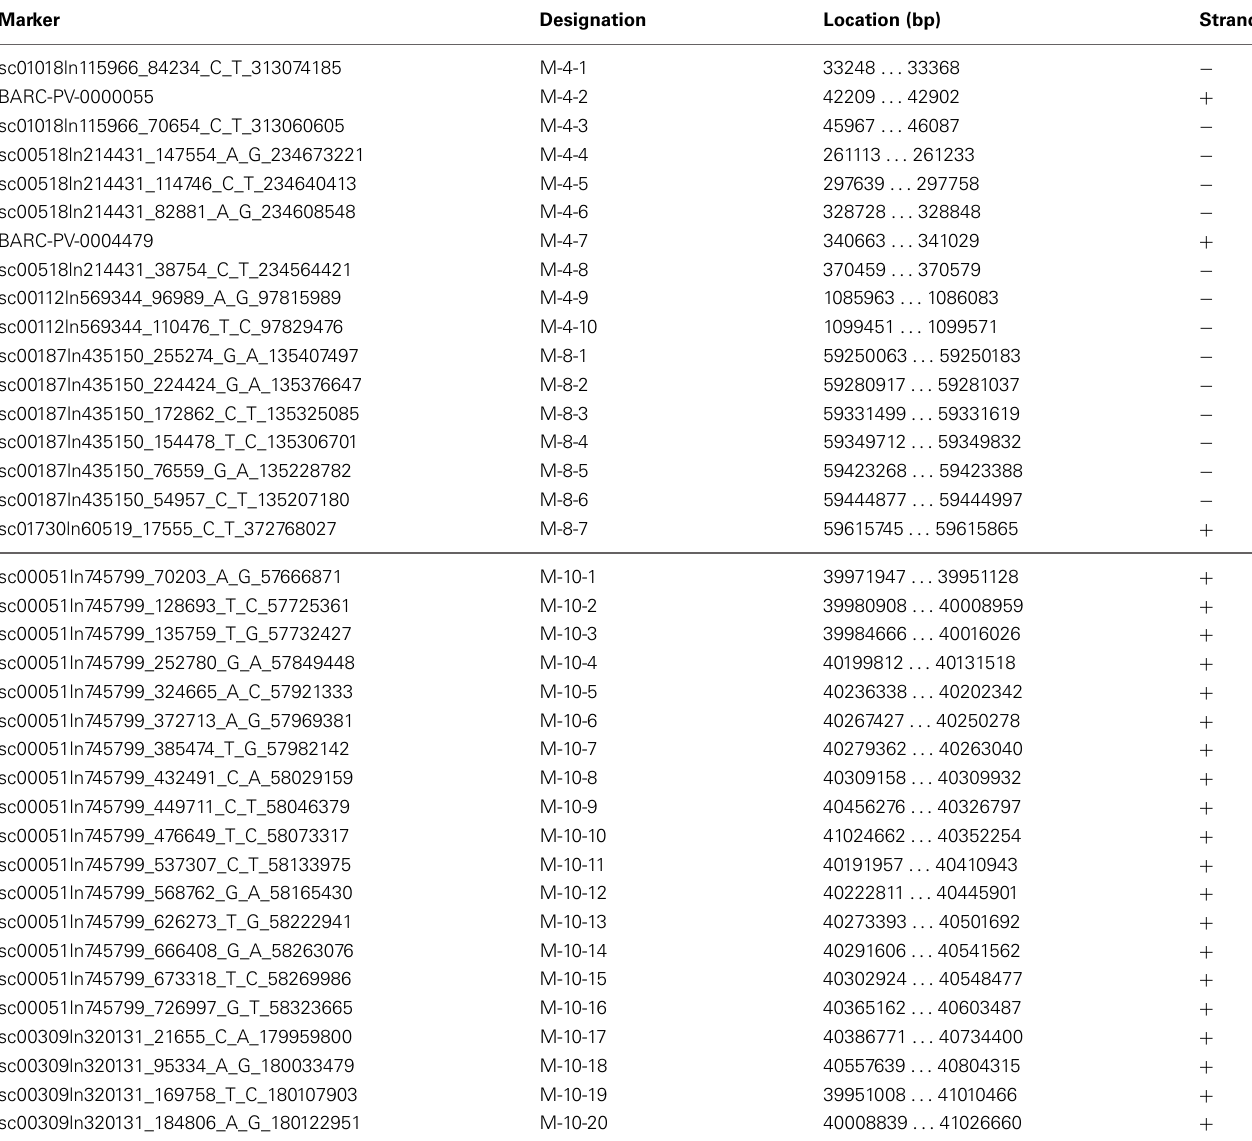
Table 1 | BeanCAP Marker locations in